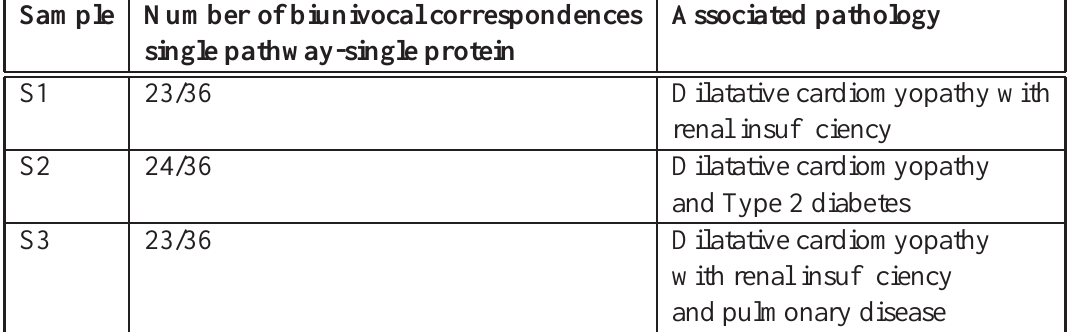
Table 1: The table outlines for each sample the relative number of pathways in which a single dysregulated protein is